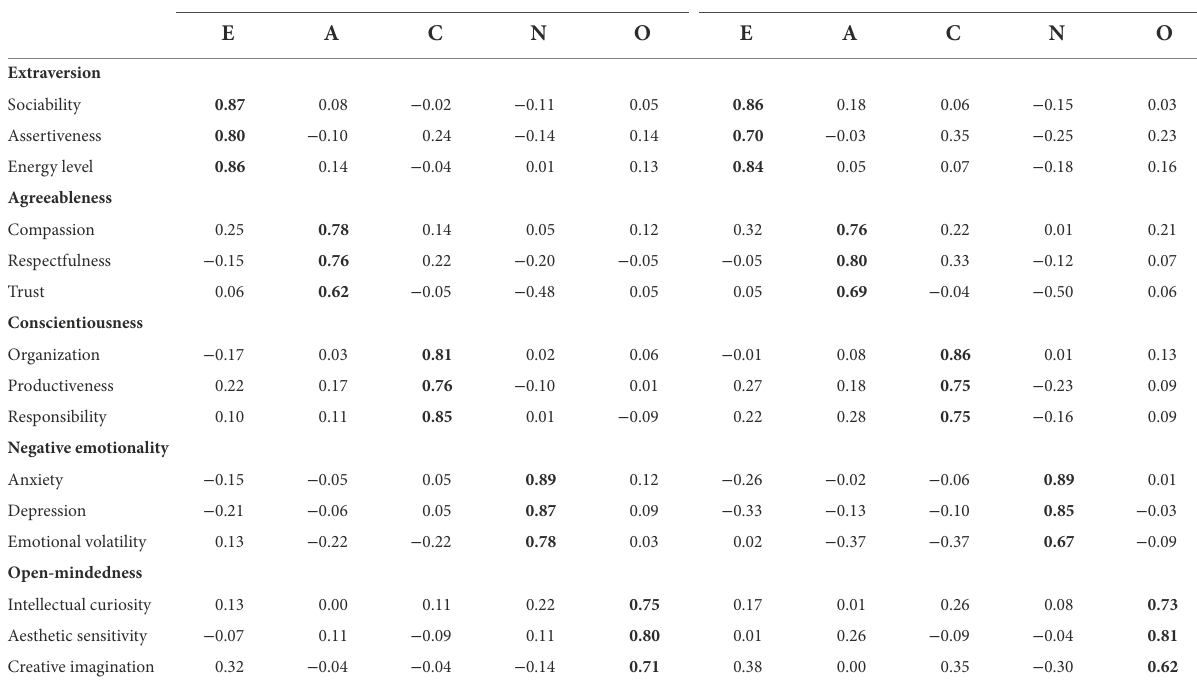
TABLE 3 Loadings from a principal components analysis of the 15 facet scores. Student